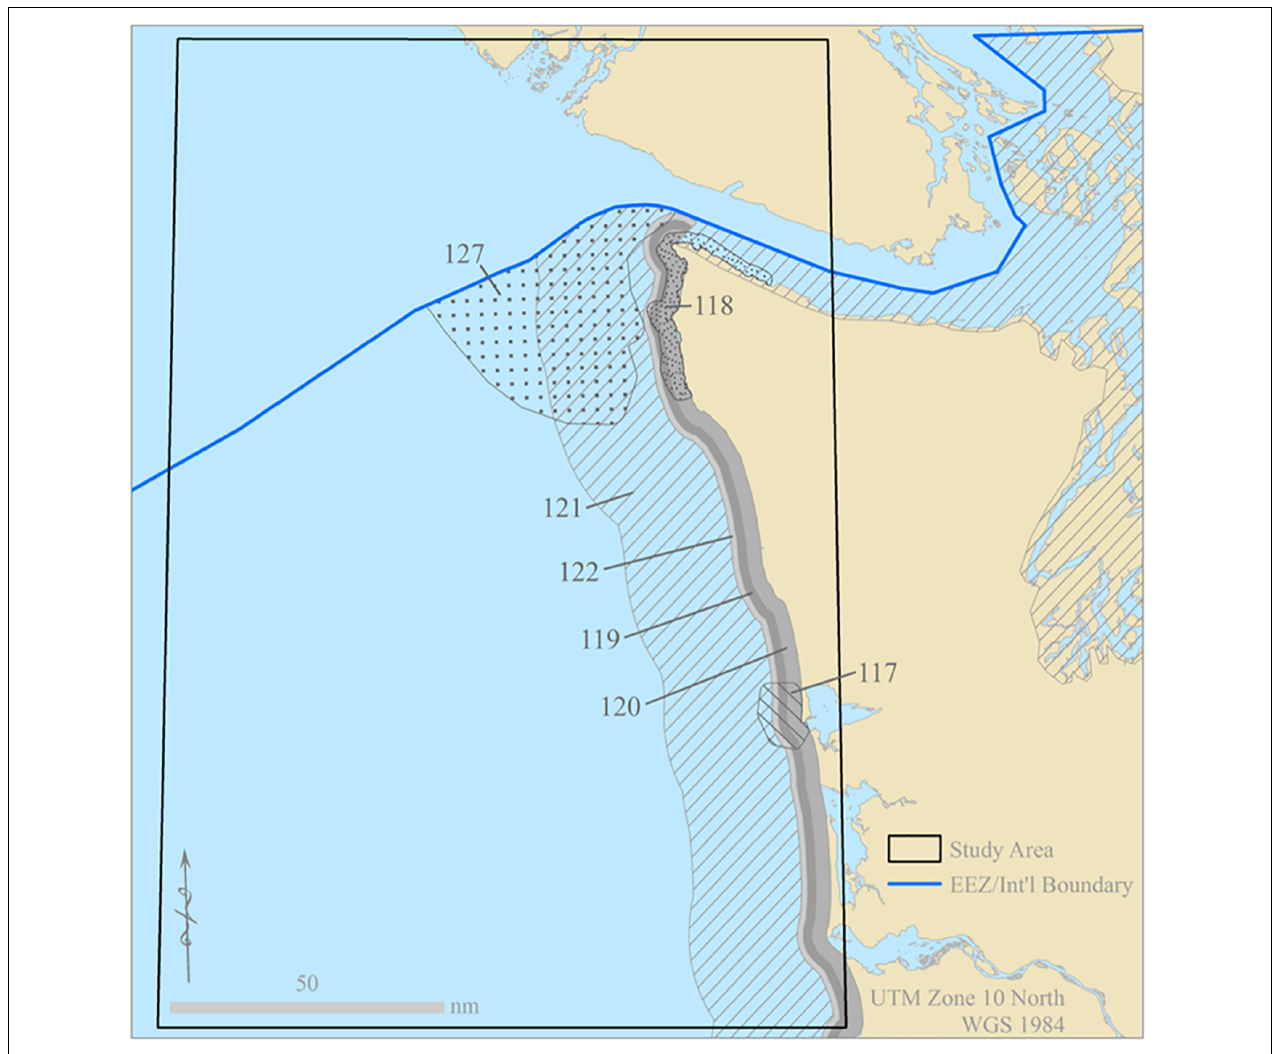
FIGURE 2 | Biologically Important Areas (BIA) (see Table 1 for species and type) for gray ( Eschrichtius robustus ) and humpback whales ( Megaptera novaengliae ) along the coast of the North American Pacific Northwest (Calambokidis et al., 2015). All BIAs are for gray whales with the exception of BIA 127 for humpback